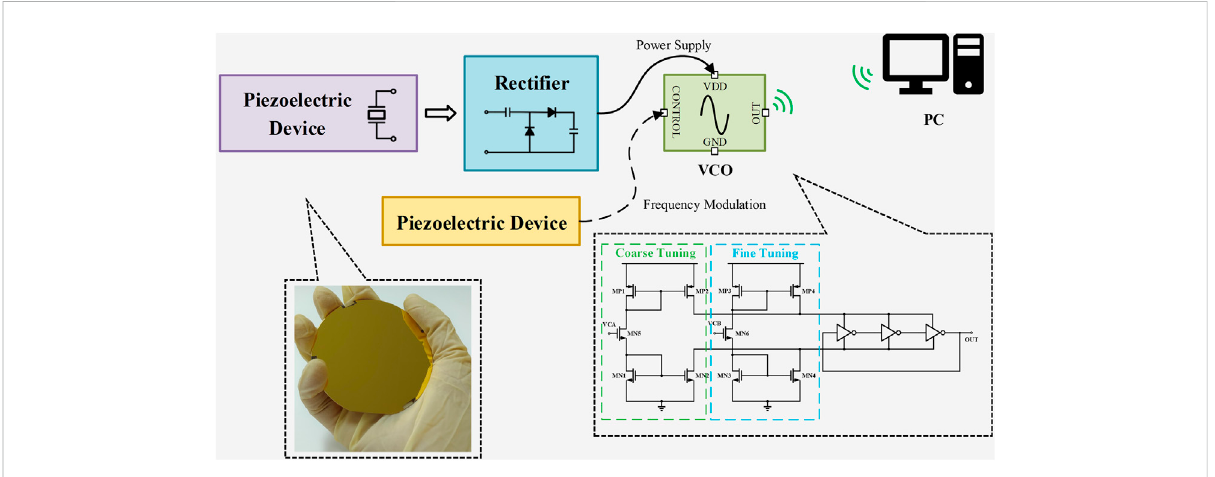
FIGURE 1 Structure diagram of the heterogeneous integrated self-powered IoT system. The piezoelectric device realizes energy harvesting through the recti fi er and supplies power to the VCO, and the piezoelectric device is connected to the control terminal of the VCO to realize frequency